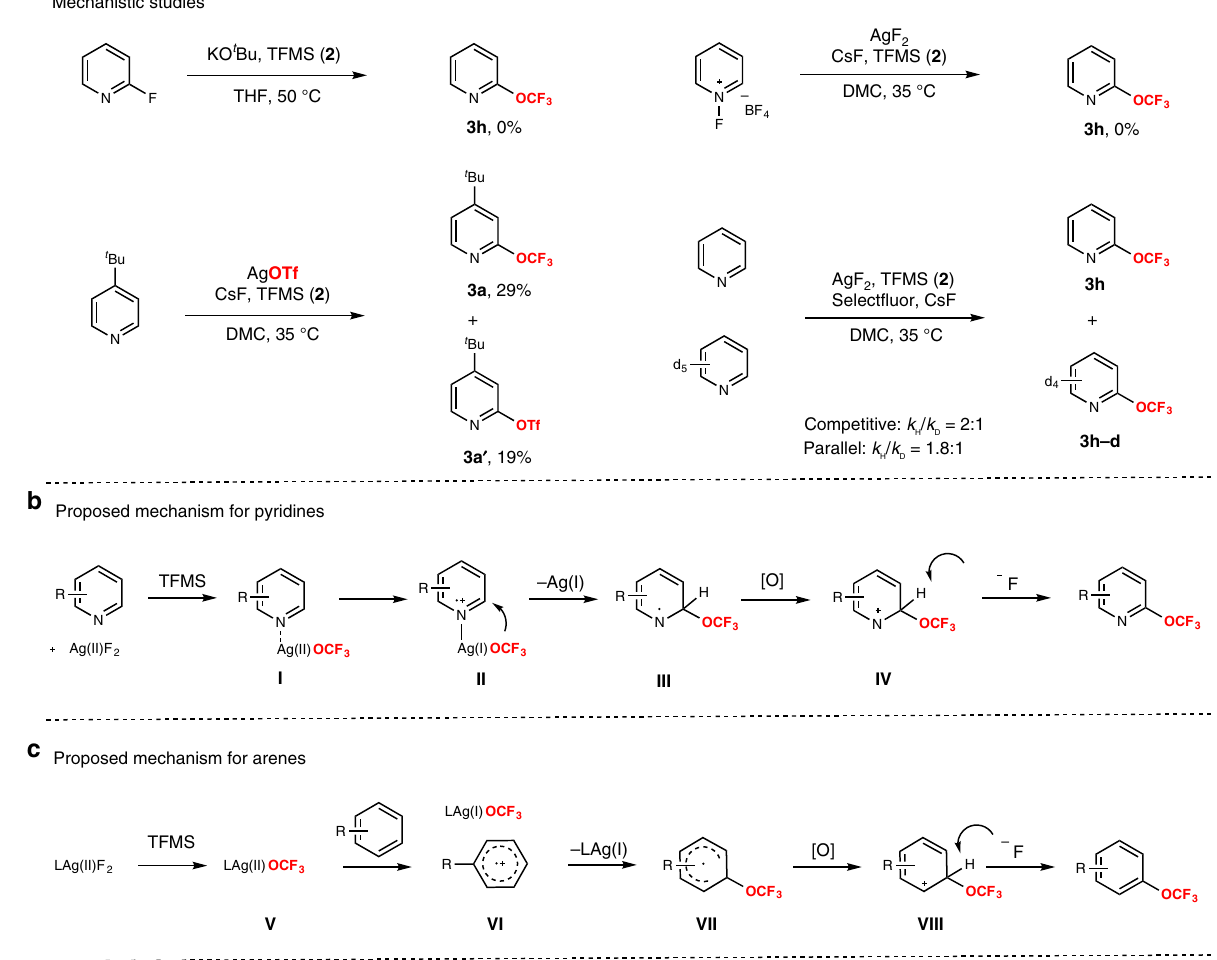
Fig. 4 Mechanistic studies and proposed mechanism. a Mechanistic studies. b Proposed mechanism for pyridines. c Proposed mechanism for ( o : m : p ) isomers via an OCF 3 radical by Ngai 52,68 . Finally,